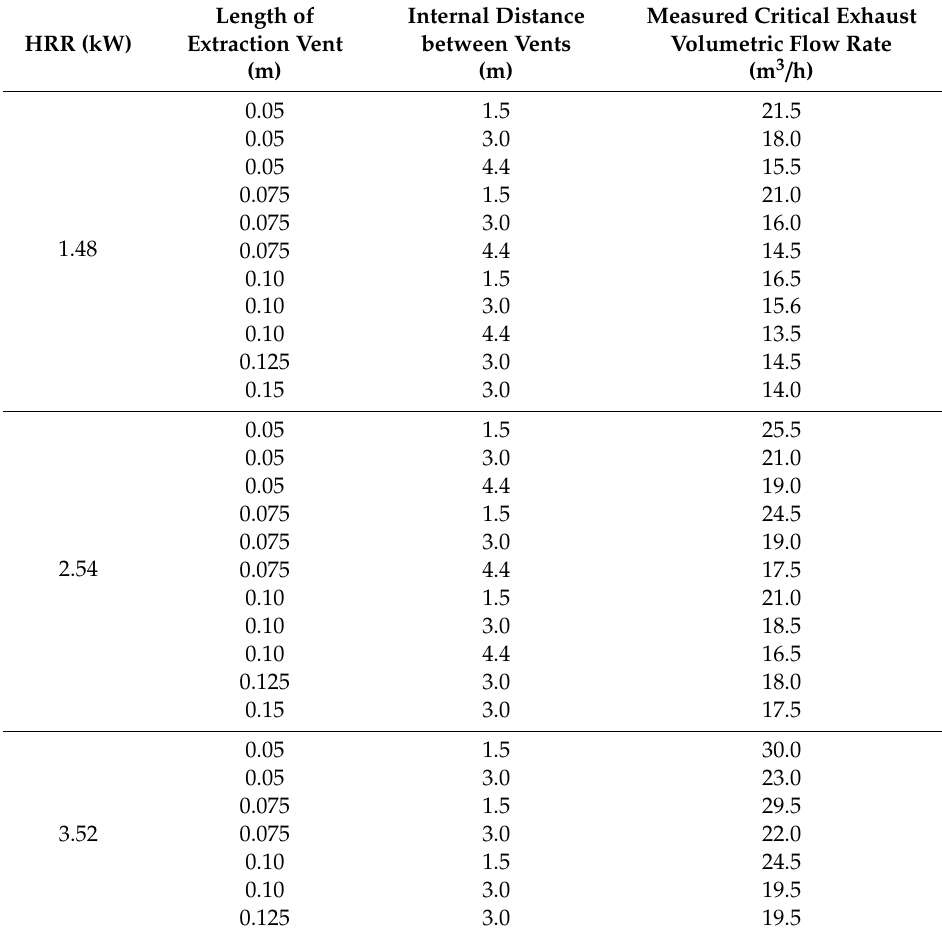
Table 3. Summary of experimental results on critical exhaust volumetric flow